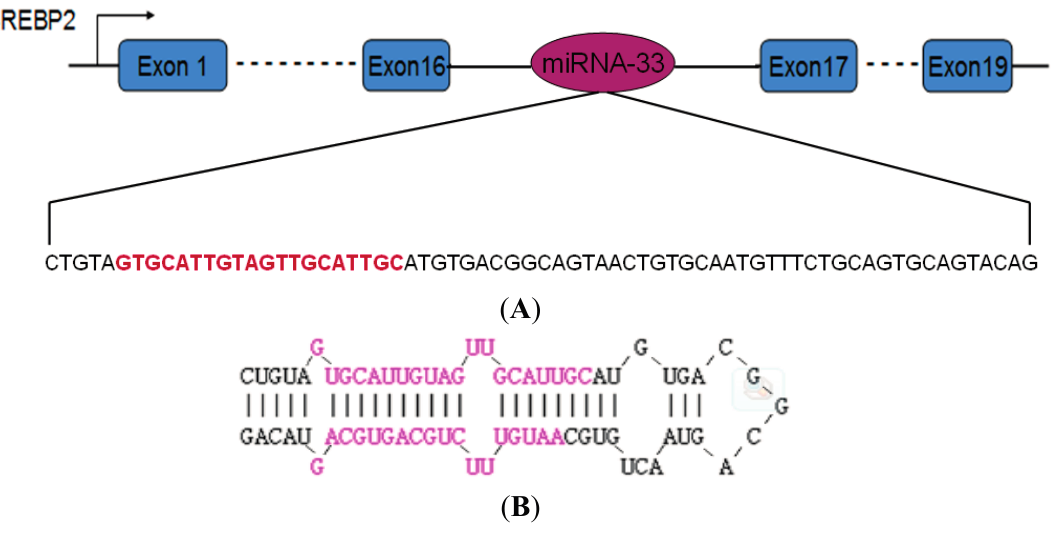
Figure 1. miR-33 precursor sequence and stem ring structure. ( A ) miRNA-33 located in SREBP2 intron 16. The sequence above is the precursor sequence of miRNA-33 in Landes geese. The part of the sequence that is marked in red indicates mature sequences; ( B ) Structure of the stem ring of the miRNA in Landes geese. The part of the sequence that is marked in red represents mature